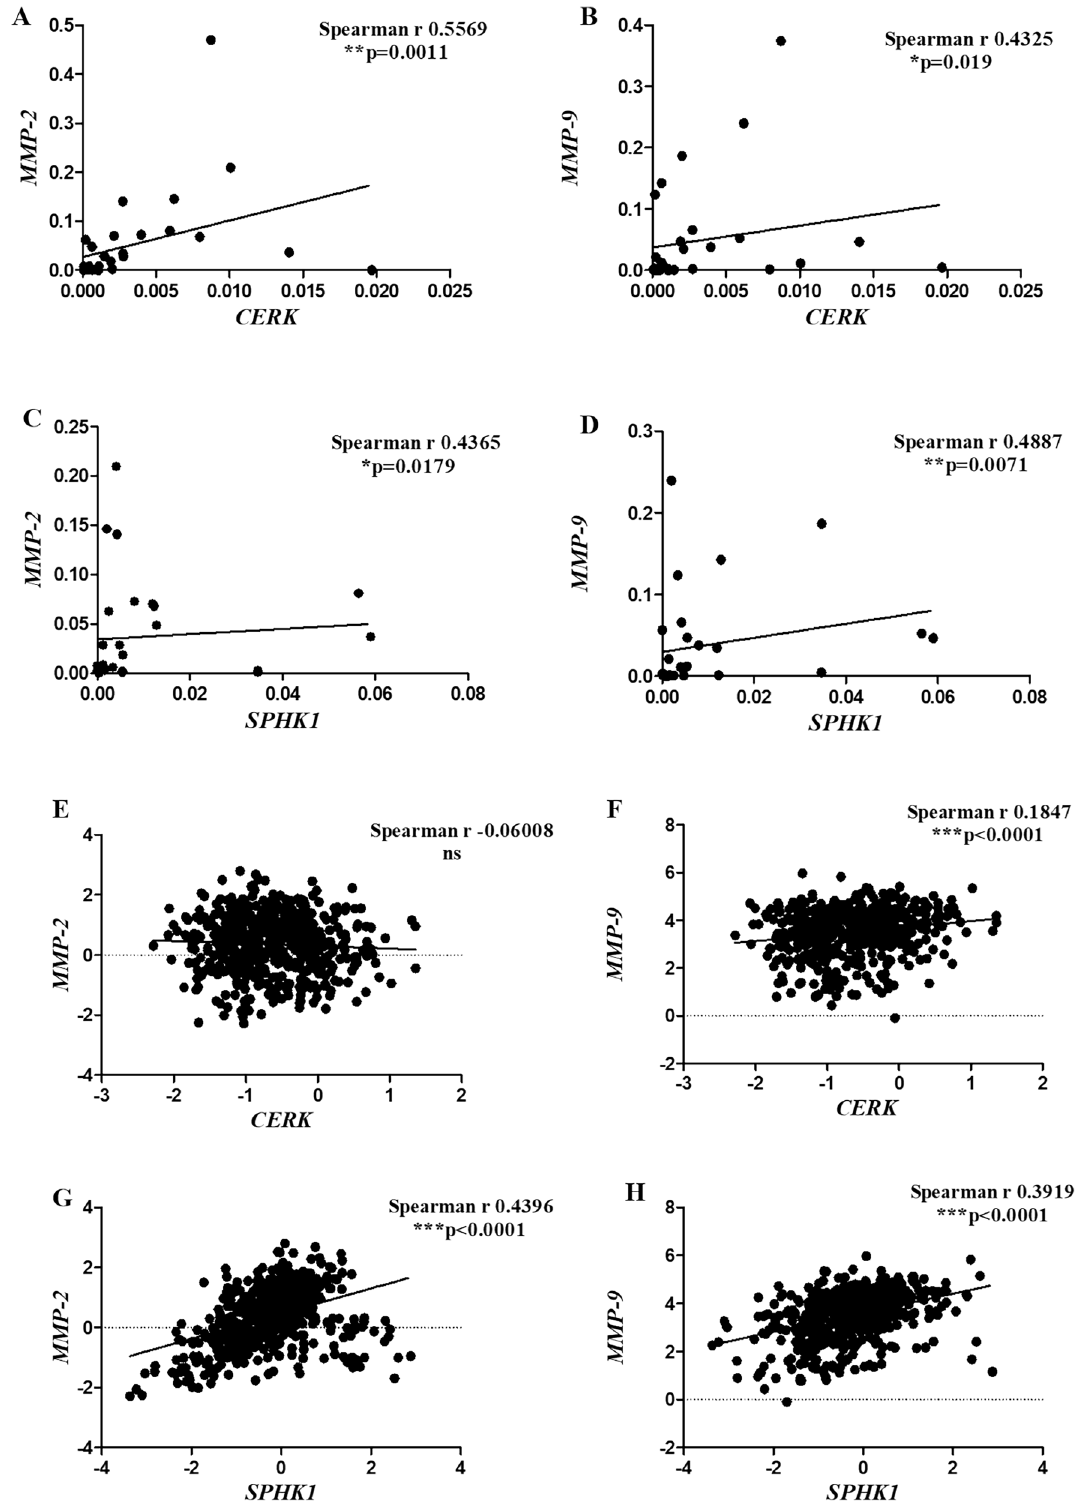
Figure 8. Correlation of CERK with ( A ) MMP-2 , ( B ) MMP-9 and SPHK1 with ( C ) MMP-2 , ( D ) MMP-9 in local cohort and CERK with ( E ) MMP-2 , ( F ) MMP-9 and SPHK1 with ( G ) MMP-2 , ( H ) MMP-9 in TCGA